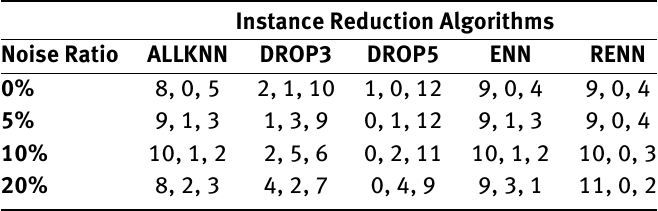
Table 10: Total Number of datasets with affected average accuracy (++, unknown, –) for unpruned trees at different noise